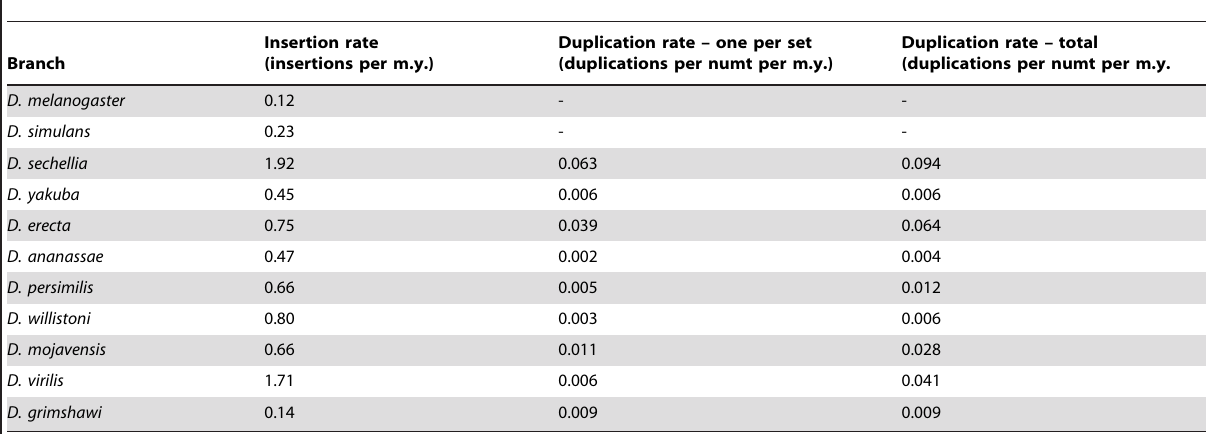
Table 3. Insertion and duplication rates for each lineage.